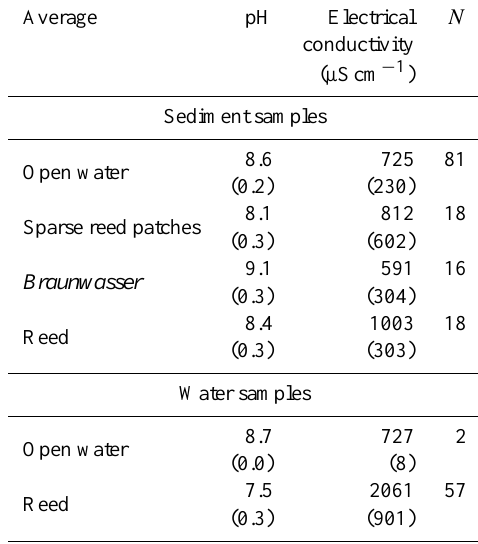
Table 2. Chemical parameters (pH, electrical conductivity) for all sediment and water